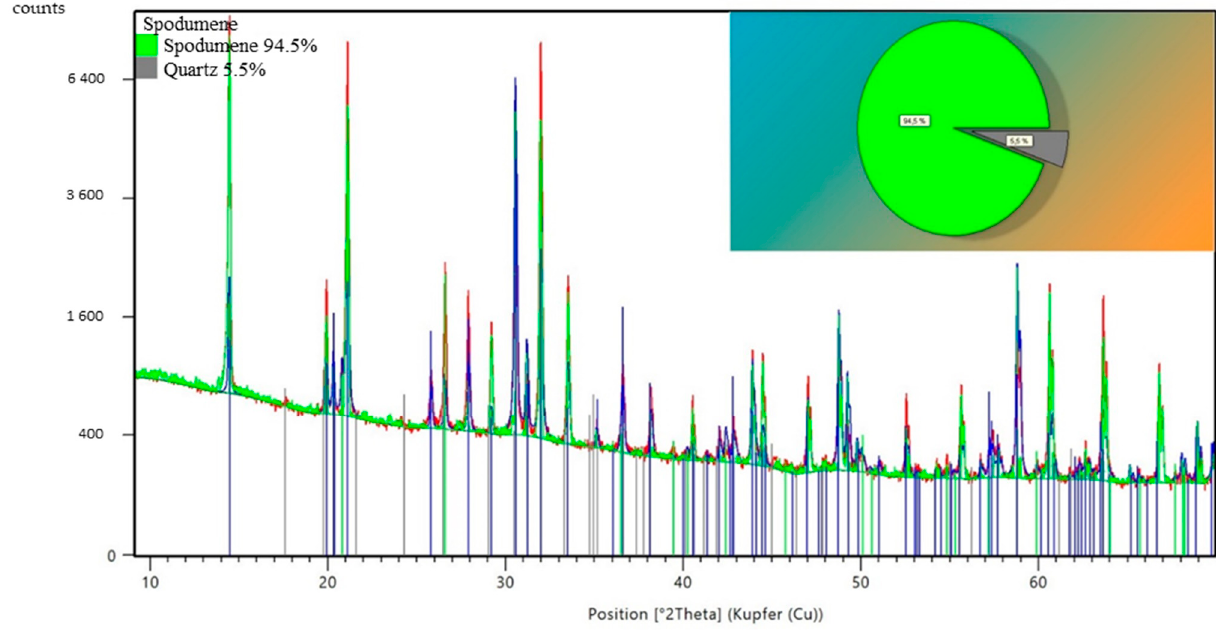
Figure 9. Rietveld refinement of a spodumene–quartz mixture. It is also possible to cluster these spodumene containing mixtures in three different lithium grade ores as given in Figure 10 (low, medium, and one high lithium containing grade). The detection limit of spodumene was also determined.